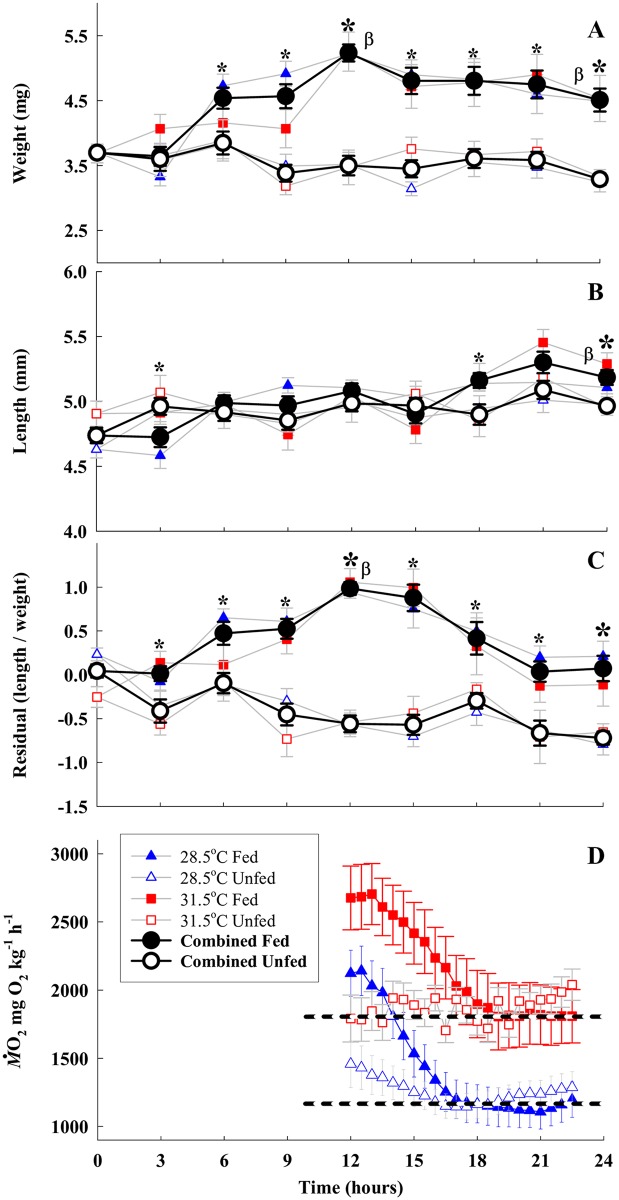
Mean (±SE) weight (A), standard length (B) and condition factor (C), of fed (filled symbols) and unfed (open symbols) larval Amphiprion percula at 28.5°C (blue) and 31.5°C (red) over 24 h, and metabolic rate (D) over 12 h.Data for each of the two temperatures are presented as blue and red symbols in the background of (A) through (C), but temperatures were combined (black symbols) after statistical analyses revealed no differences between temperatures (see text). * denotes significant difference between fed and unfed treatments within a time point. β denotes significant differences compared with time 0 at 12 h (beginning of food restriction for fed fish) and 24 h (once postprandial processes were complete). Open symbols in (D) represent unfed fish, while filled symbols represent fed fish. The horizontal black dashed lines in (D) show Mo2 routine at 28.5°C (lower line) and 31.5°C (upper line). Statistical analyses for the data in (D) are presented in the text.